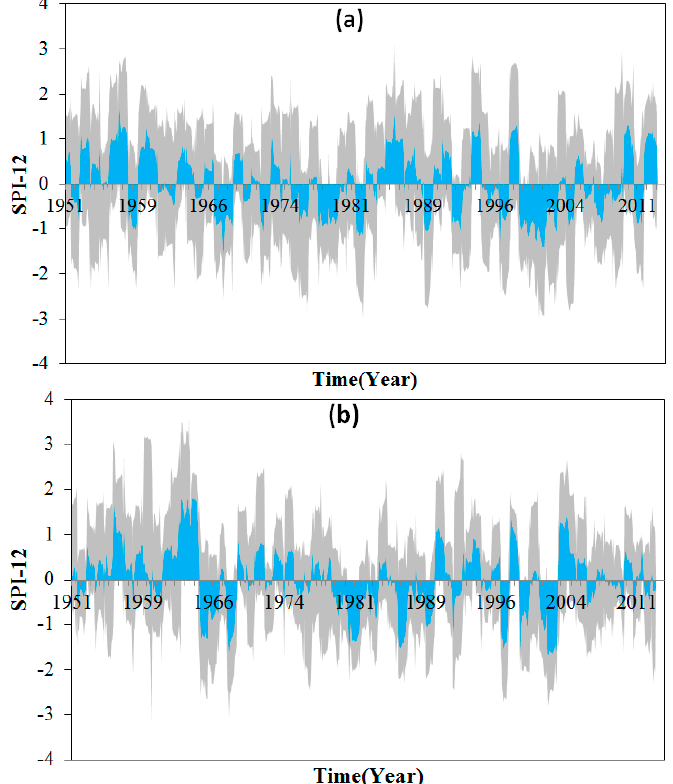
Figure 2. The SPI values for 1951–2013 for ( a ) Northeast China and ( b ) Huang–Huai–Hai.